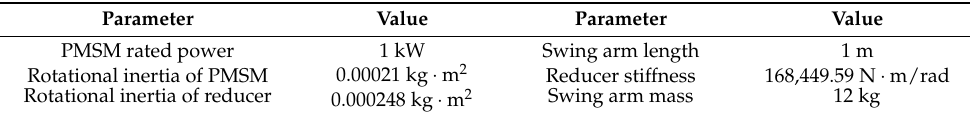
Figure 7. The single-degree-of-freedom rotary arm test stand. Table 1. Test bench parameters.